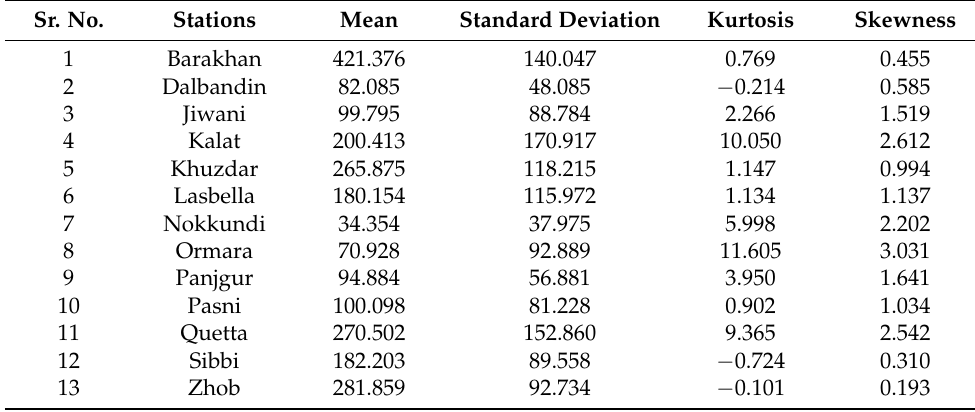
Table A1. Linear regression on the annual time series.